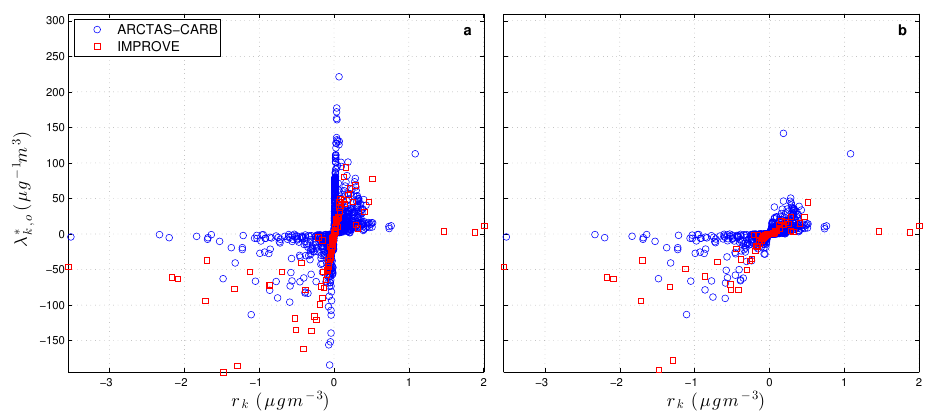
Figure 9. Adjoint forcing ( λ ∗ ) vs. residual error ( r k ) for ARCTAS and IMPROVE observations using weights of (a) w k = 1 and (b) w k k,o from Eq. (27).